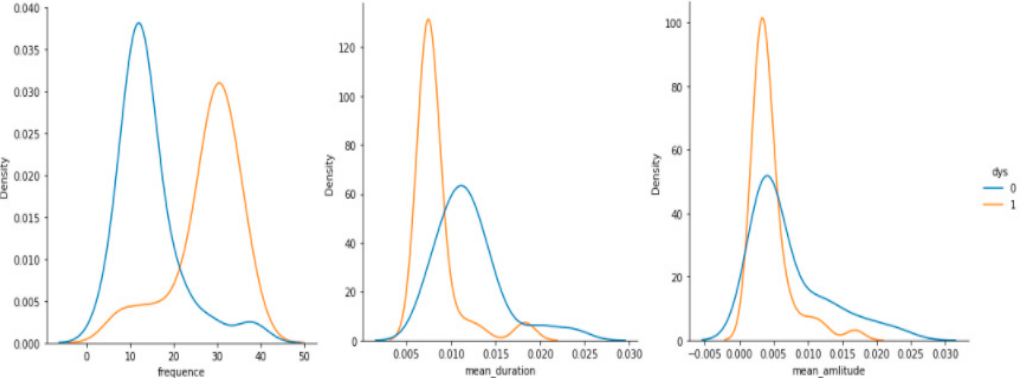
Figure A6. Distribution of the DGI for the painting 2 dataset.